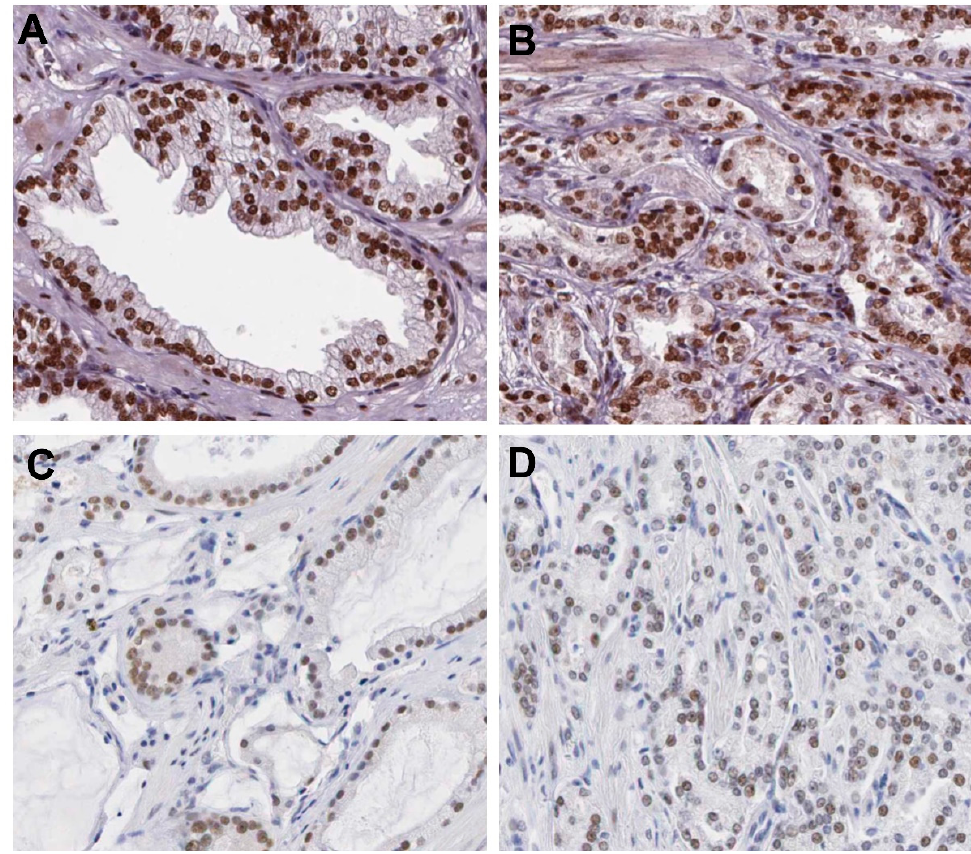
Figure 4. AR immunohistochemical expression human prostatic samples. ( A ): Normal prostate gland demonstrating strong nuclear AR expression in luminal cells. ( B ): A high-grade prostate cancer (PC) showing strong nuclear AR expression. ( C ): A low grade PC sample showing moderate AR nuclear expression. ( D ): A high-grade PC showing moderate nuclear AR expression. Image credit of the IHC images: Human Protein Atlas, www.proteinatlas.org. Image available at the following URL: https://www.proteinatlas.org/ENSG00000169083-AR/pathology/prostate+cancer, accessed on